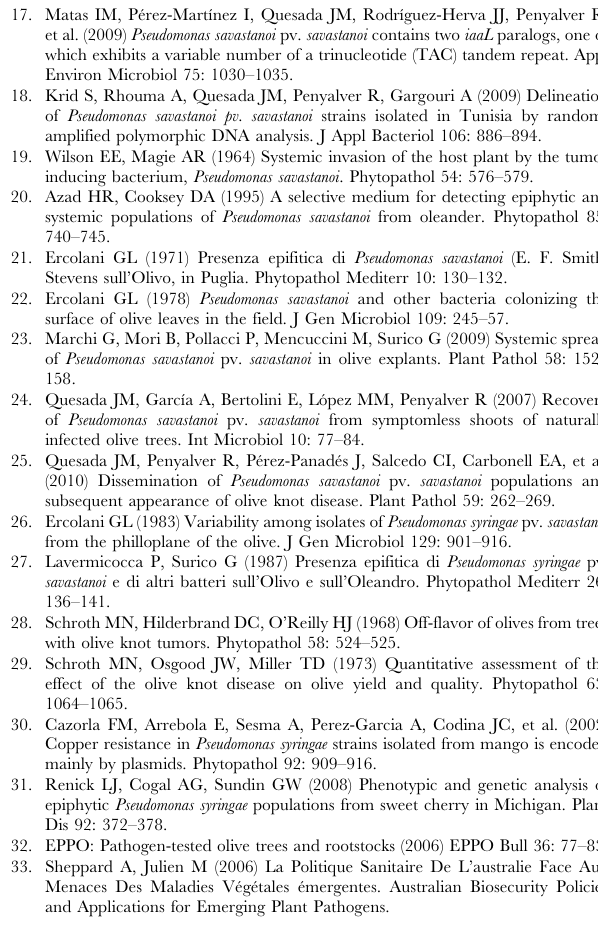
red columns represent pre- and post-melting normalization regions. (TIF) Table S1 Bacteria related to P. savastanoi or ubiqui- tous used in this study. Table S2 Identification of epiphytic bacterial genera present on Oleander leaf washings using 16S rDNA gene sequencing, according to BLAST